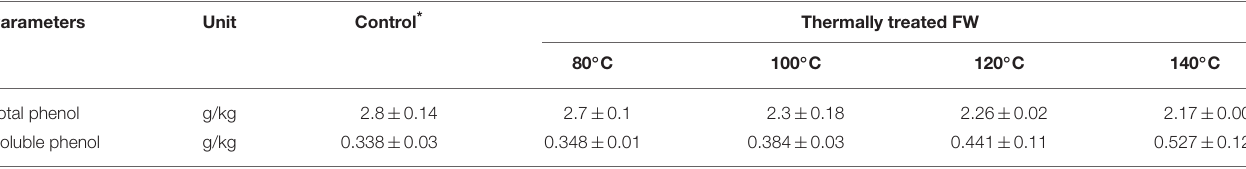
TABLE 4 | Total and soluble phenol concentration before and after each TP.